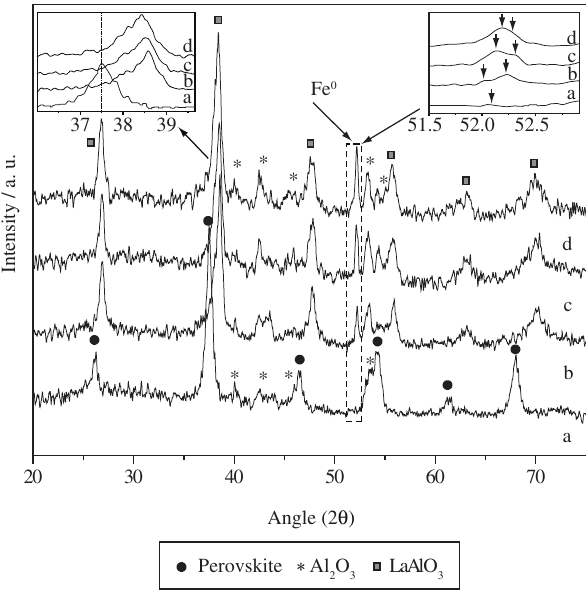
Figure 7. Powder X ray diffraction of the perovskite LaFe